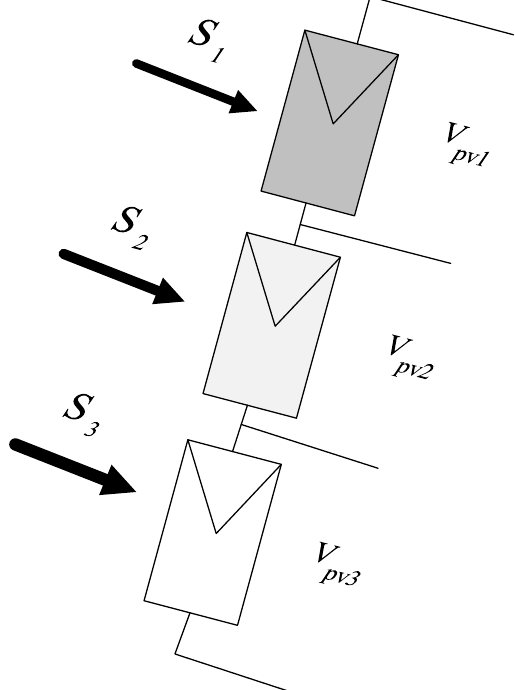
Figure 4. PV under partial shading.